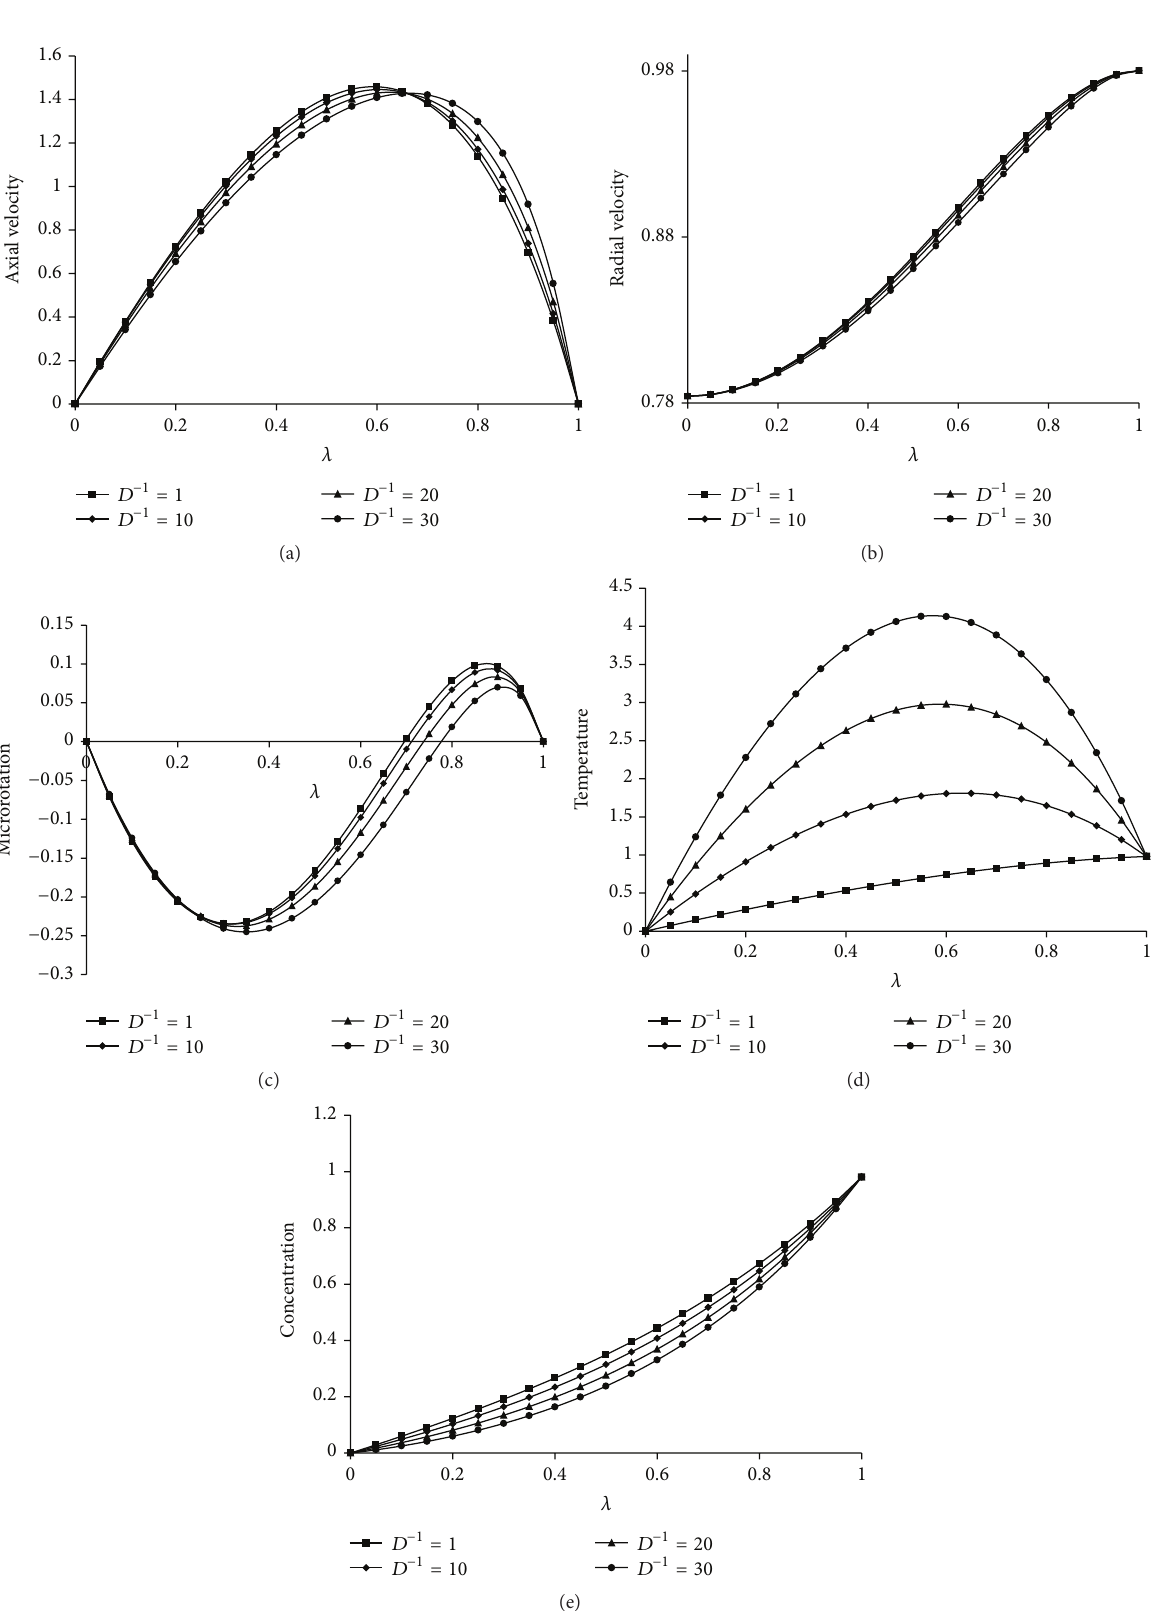
Figure 8: Effect of 𝐷 −1 on (a) axial velocity, (b) radial velocity, (c) microrotation, (d) temperature, and (e) concentration for Kr = 2, Du = 0.02, Gr = 4, Re = 2, Sr = 0.2, Ha = 1, Sc = 0.2, Pr = 0.2, 𝑎 = 0.2 , 𝜓 = 0.2 , 𝑅 = 2 , 𝐽 1 = 2 , 𝑠 1 = 2 , 𝑠 2 = 2 , Gm = 4, and Ec =